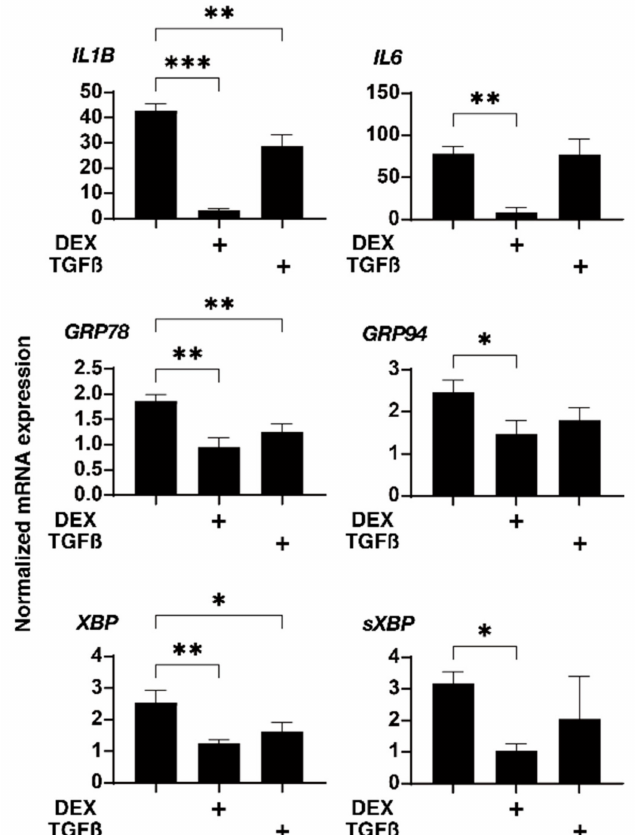
Figure 6. mRNA expression of the inflammatory cytokines and ER stress-related factors of the 3D HTM spheroids after a mechanical compression stress for 30 min. In the presence of 5 ng/mL TGF- β 2 (TGF) or 250 ng/mL DEX, the 3D HTM spheroids were mechanically compressed on day 6 for 30 min and subjected to a qPCR analysis to estimate the expression of mRNA of the inflammatory cytokines (IL1 and IL6) and ER stress-related factors (glucose regulator protein (GRP) 78, GRP94, X-box binding protein 1 (XBP1), and spliced XBP1 (sXBP1)). These data were compared with those of the untreated 3D HTM spheroids compressed for 30 min (as above). All the experiments were performed in duplicate using fresh preparations ( n = 4). The data are presented as the arithmetic means ± standard error of the mean (SEM). Note: * p < 0.05, ** p < 0.01, *** p < 0.005 (ANOVA followed by Tukey’s multiple comparison